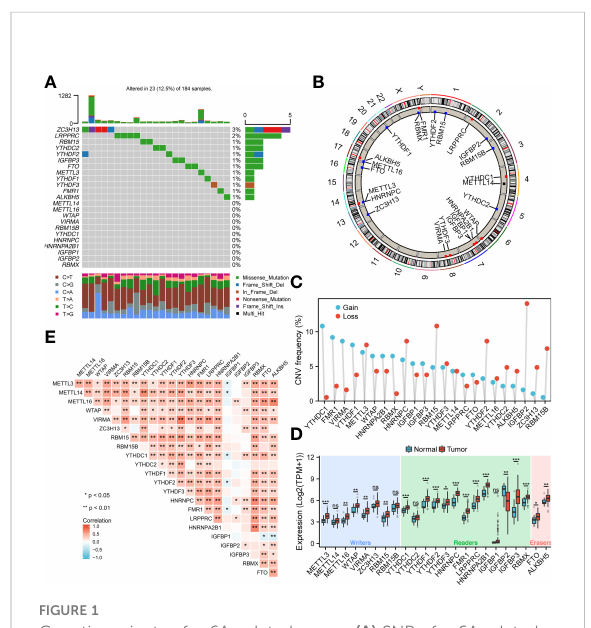
FIGURE 1 Genetic variants of m6A-related genes. (A) SNP of m6A related genes in 23 samples. (B) Location of CNV alterations on chromosomes. (C) Frequency of CNV in m6A related genes. Blue represents ampli fi cation, orange represents deletion. (D) Genetic variants of m6A-related genes. (E) Diagram showing the relationship between different m6A-related genes through Pearson correlation analysis. Red and blue represent a positive and negative correlation, respectively. *p < 0.05, **p < 0.01, ***p < 0.001; ns, not signi fi cant.